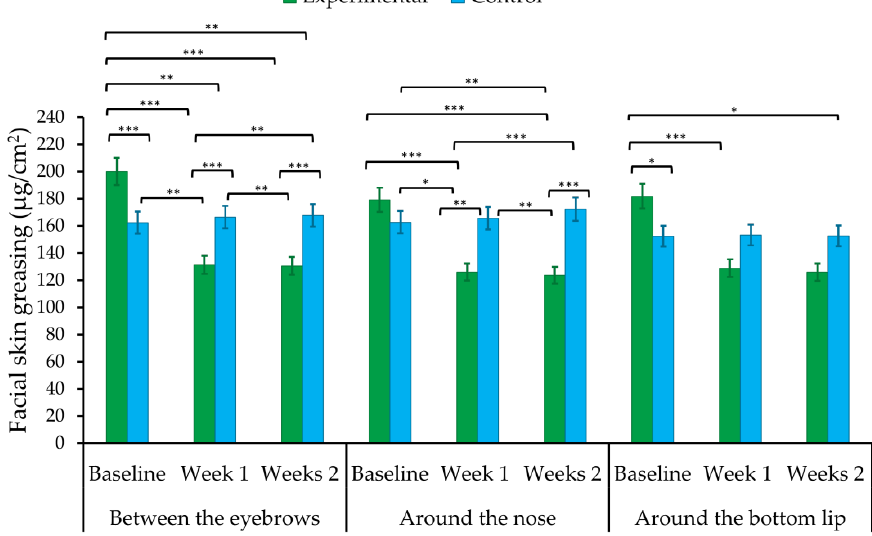
Figure 4. Mean scores of skin greasing at baseline, week 1, and weeks 2 after completion of sonophoresis treatment in the experimental and control groups. * p < 0.05, ** p < 0.01, *** p < 0.001.